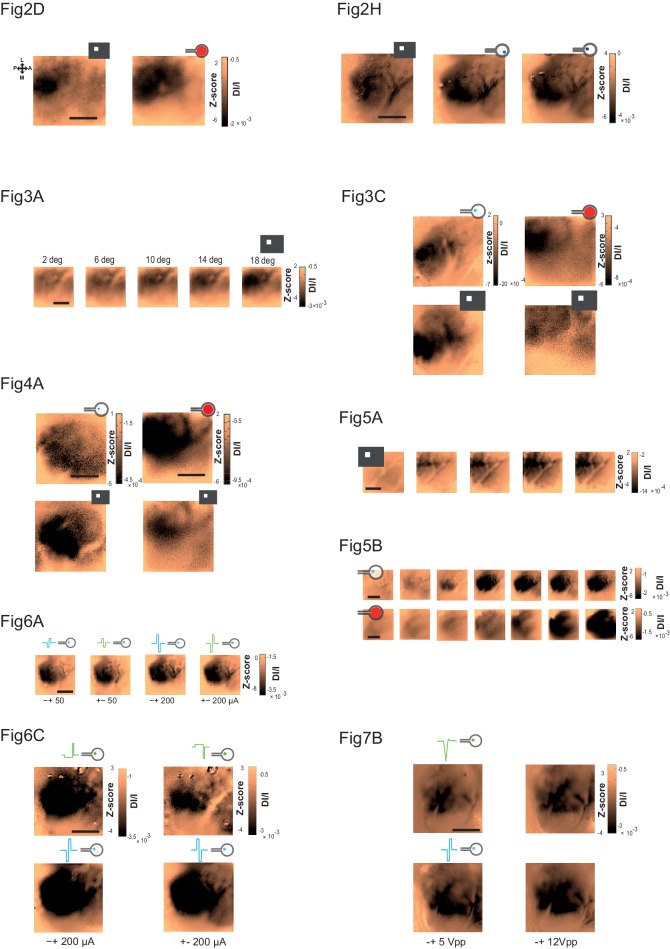
Raw maps.Raw z-score maps without overlaid contours corresponding to a sample of figures presented in the manuscript (see subtitles). Colorbars are expressed both in z-score as well as in DI/I.